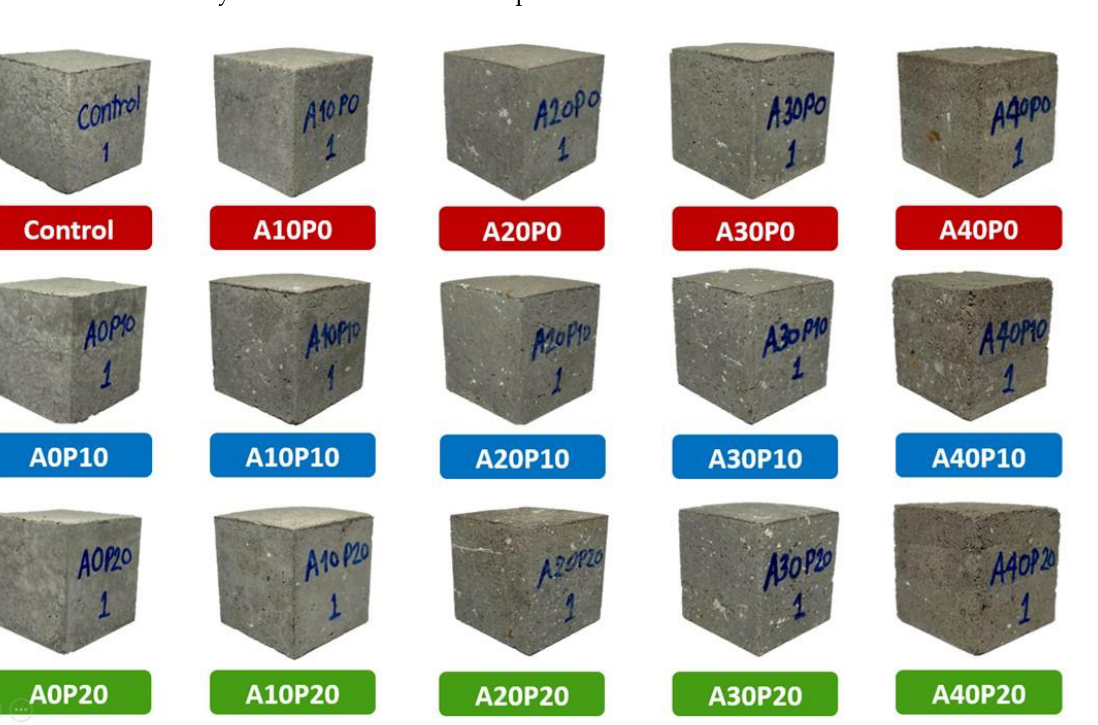
Table 3. Leaching of heavy metals from MIBA.